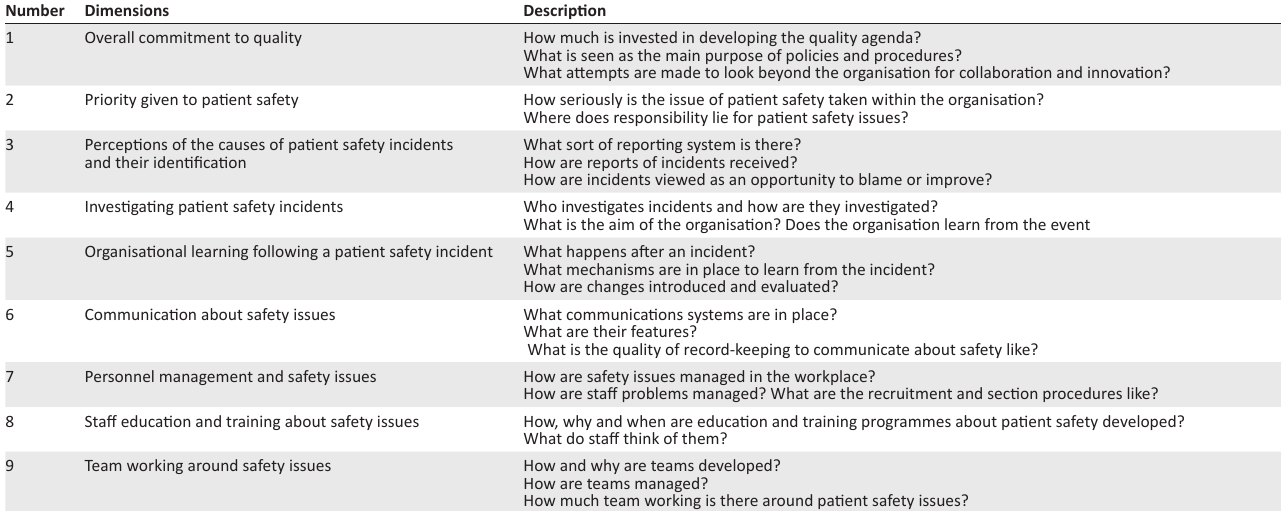
TABLE 1: The nine quality dimensions of the Manchester Patient Safety Framework. Number